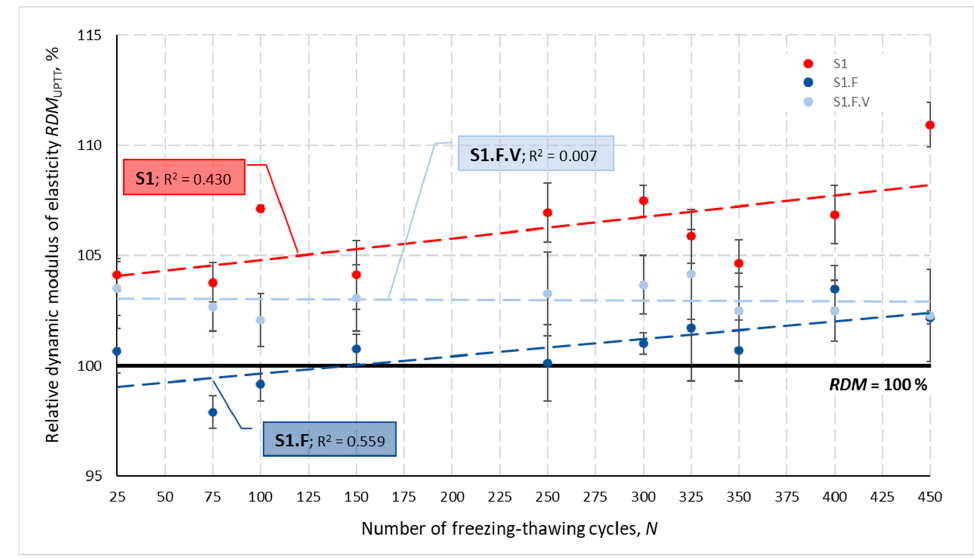
Figure 15. Mean relative dynamic modulus of elasticity for S1, S1.F and S1.F.V concretes after N cycles of freezing and thawing.